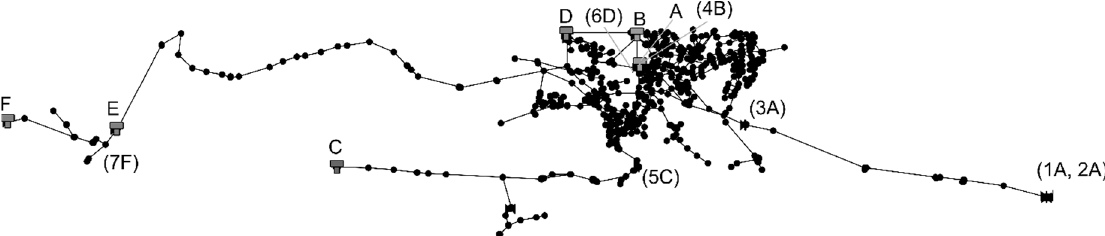
Figure 9. Richmond distribution network.